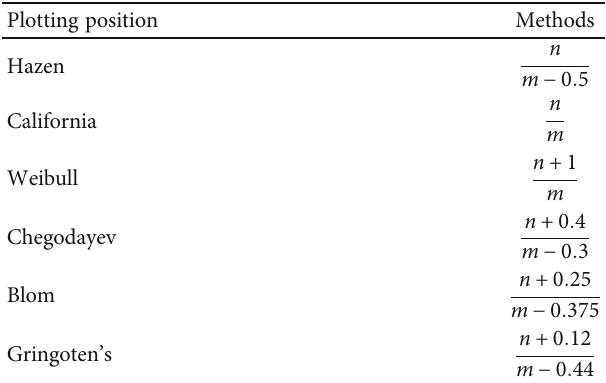
Table 1: Position formulae tested. Plotting position